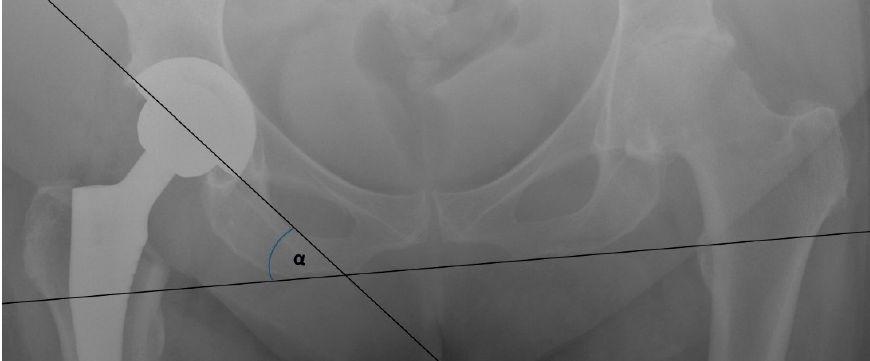
Figure 3. Cup inclination measurement.